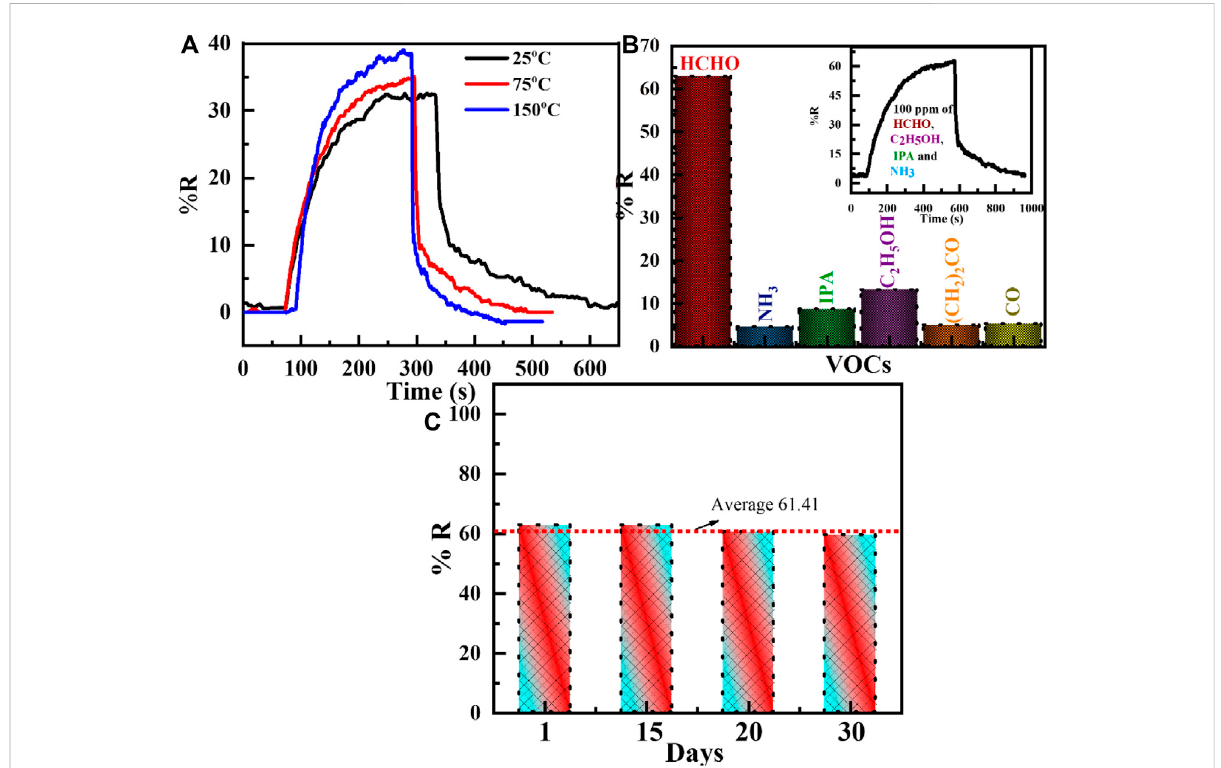
FIGURE 6 (A) Transient responses of the WO 3 -Ni-Gr composite toward 50 ppm of formaldehyde (HCHO) for different temperatures such as 25 ° C, 75 ° C, and 150 ° C. The response of the sensor to HCHO gas increases as the temperature increases. (B) Histogram of the sensing response of WO 3